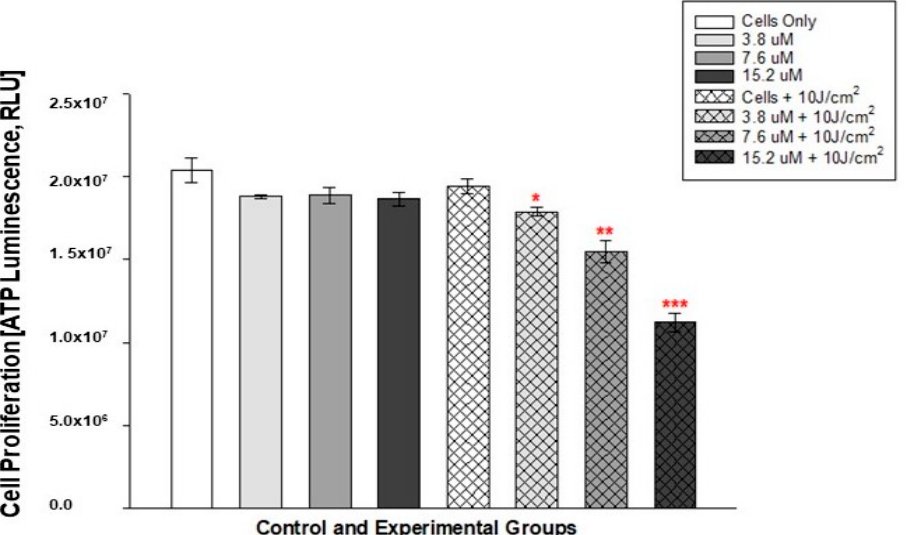
Figure 8. ATP luminescence after 12 h post PDT with a laser fluence of 10 J/cm 2 . Significance is shown as * p < 0.05, ** p <0.01 and *** p < 0.001 (SEM). Experiment was repeated three time (n = 3).